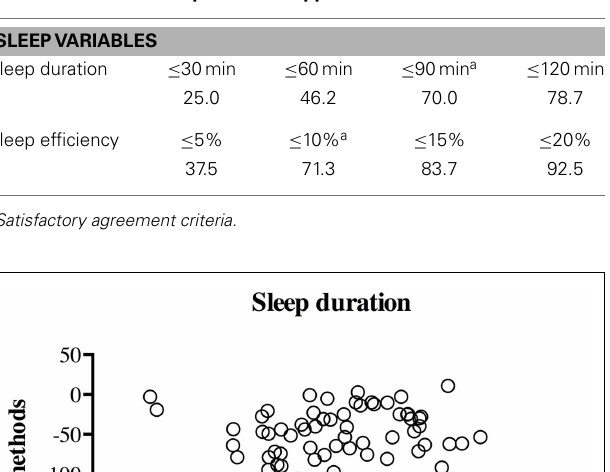
Table 5 |Agreement between actigraphy and sleep diaries using the Bland andAltman non-parametric approach .